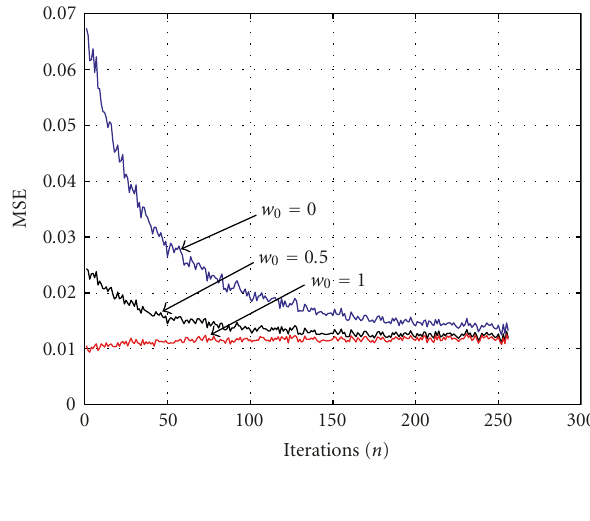
Figure 7: BER performance of the first and second stage of the APIC as a function of the step-size.